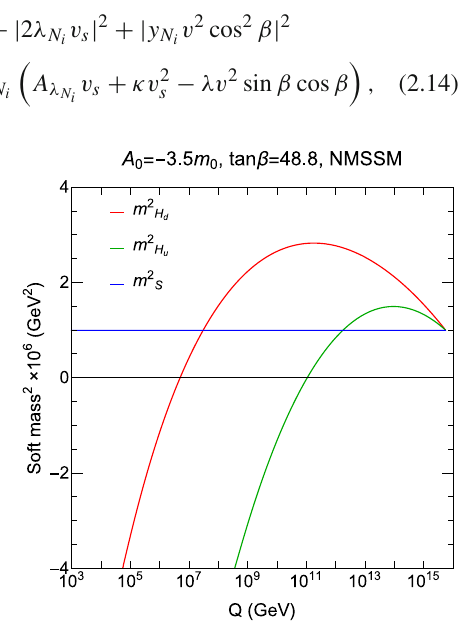
Fig. 1 Two-loopRGErunningofthesoftHiggsmassparameters, m 2 m 2 , and m 2 , imposing the universality condition m 0 = 1000 GeV H u S at the GUT scale, with A 0 = − 3 . 5 m 0 , m 1 / 2 = 4500 GeV, and λ = 0 . 01 (the latter is input at the weak scale). The plot on the left